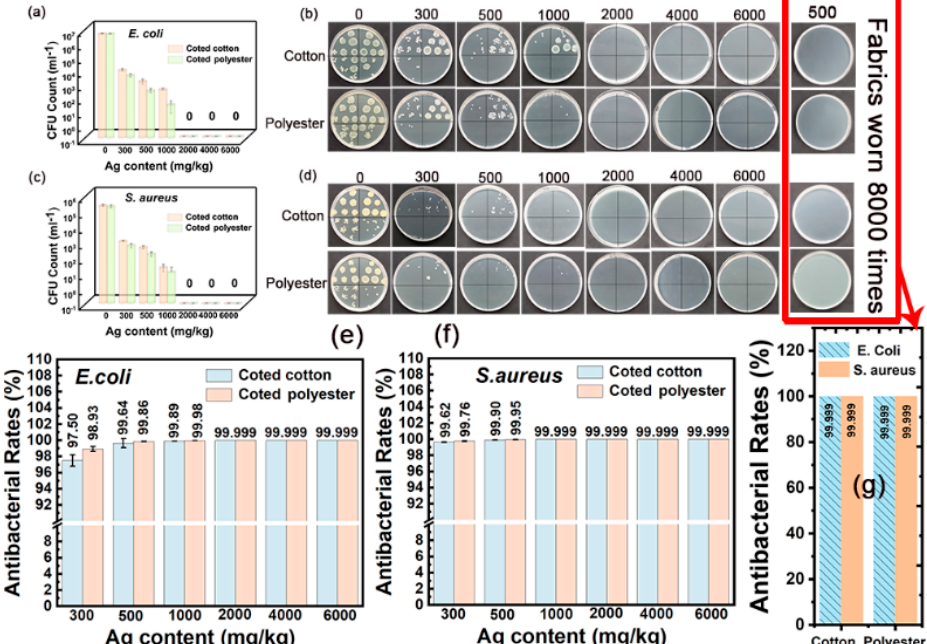
Figure 11. Antibacterial activities of nanosilver-glue-coated cotton and polyester fabrics against E. coli and S. aureus for 100 cycles of standard washing and 8000 times of abrasion. ( b , d ) Corresponding photos of E. coli and S. aureus colonies in culture dishes. ( a , c ) CFU counts of cotton and polyester fabrics for 100 times of washing after incubation, and ( e , f ) corresponding antibacterial rates against E. coli and S. aureus . ( g ) Antibacterial rates of coated cotton and polyester fabrics (500 mg/kg) worn 8000 times against E. coli and S. aureus .